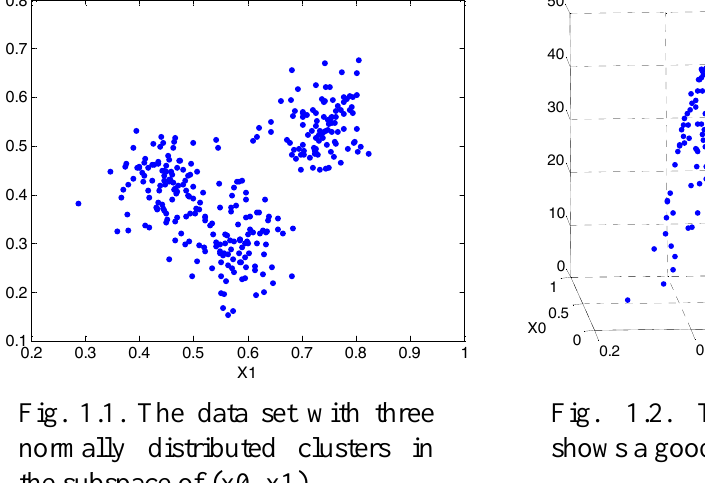
Fig. 1.1. The data set with three normally distributed clusters in the subspace of (x0, x1).